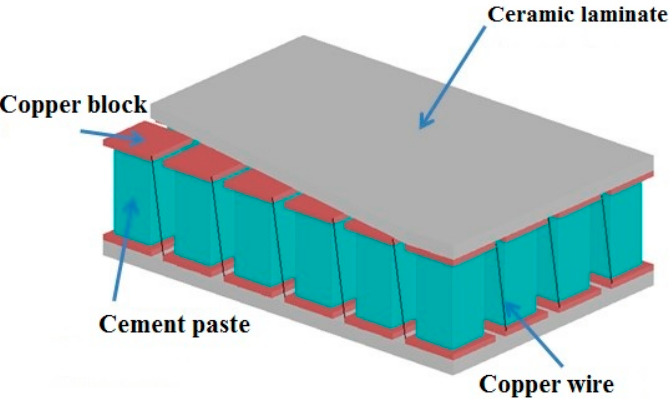
Figure 2. Schematic diagram of the cement-based thermoelectric device.